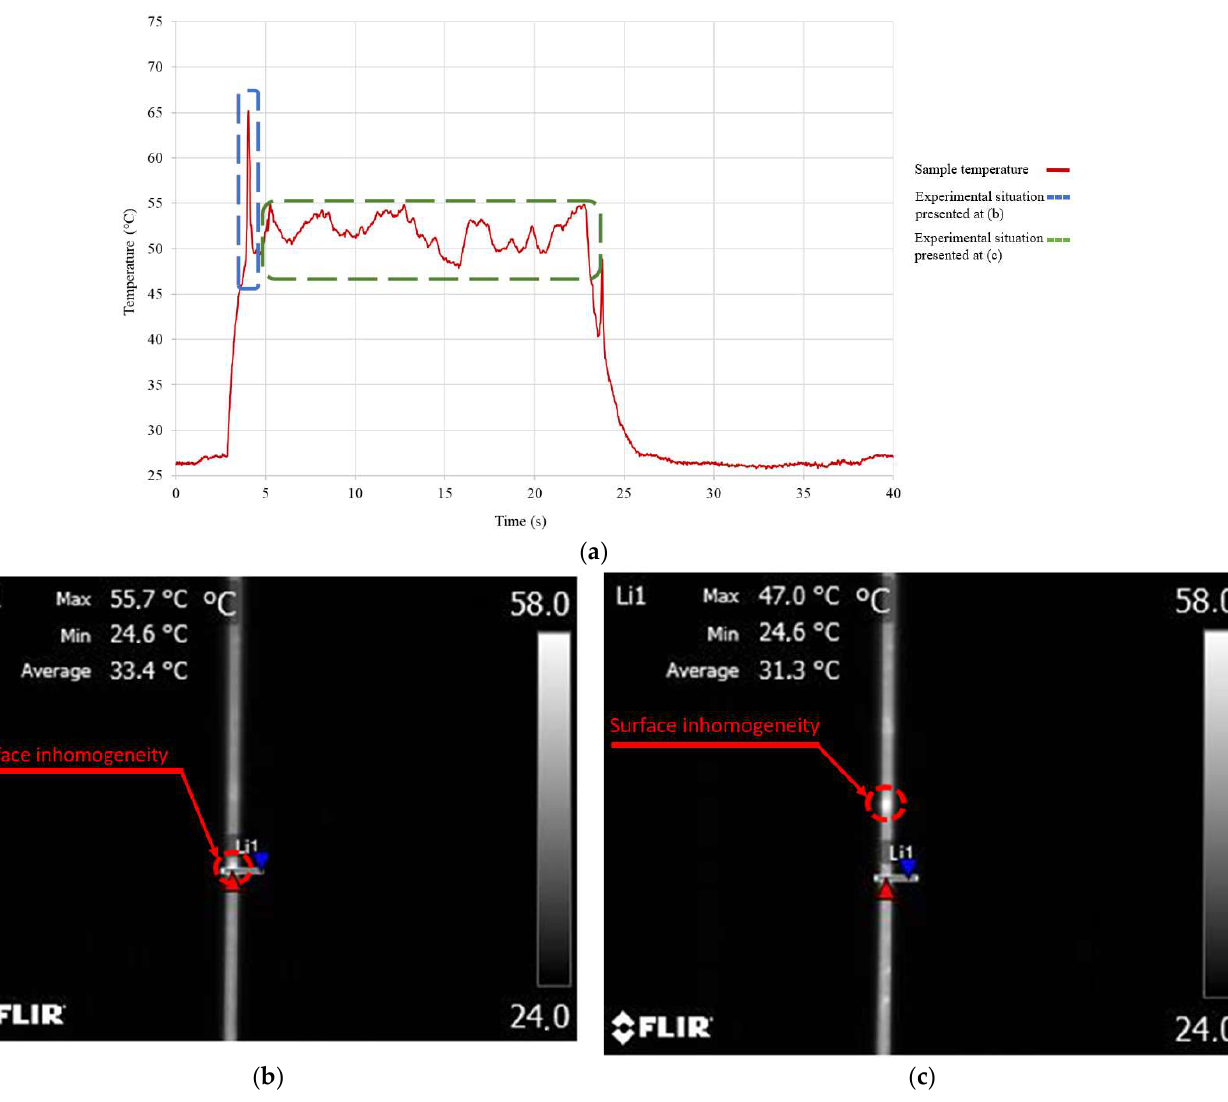
Figure 7. Effect of surface inhomogeneity on the temperature measurements. ( a ) Temperature wave- form during the measurement with 170 mA heating current, ( b ) frame from the thermographic camera during the measurements with 170 mA heating current, presenting the inhomogeneity of the surface in the measurement area, ( c ) frame from the thermographic camera during the measurements with 170 mA heating current, presenting the inhomogeneity of the surface outside the measurement area.